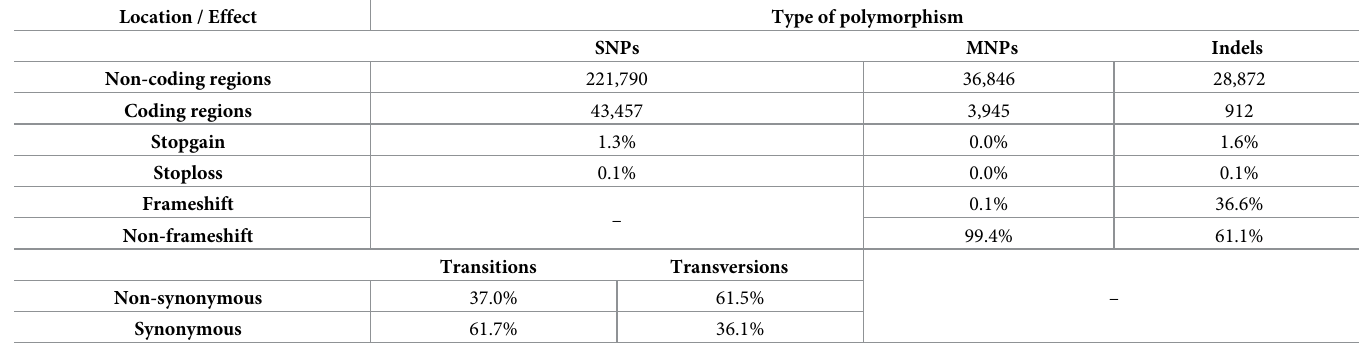
recognition sites were found for one sequence polymorphism. As could be expected based on the input file, polymorphic recognition sites were delivered mostly from SNPs (82.5%) (Table 4). CAPS-convertible fraction reached 86.1, 95.2 and 60.5% for SNPs, MNPs and indels, respectively. Among the identified CAPS markers the top represented restriction enzyme pro- totypes were: MspJ I, Sge I, Fai I and Set I with 1,590, 1,082, 763 and 582 markers, respectively. Out of the 16,093 identified CAPS markers, for 3,331 (20.7%) their constituting recognition site was not found within both 500 bp regions flanking the respective sequence polymorphism. Contribution of SNPs, MNPs and indels in the pool of such single-cut CAPS markers was sim- ilar to that before filtration (Table 4). Within the single-cut fraction the top represented proto- types were: Mae II, Tsp GWI, Hga I and Bsr I with 52, 51, 40 and 36 markers, respectively. Generally, the run time of VCF2CAPS was proportional to the number of DNA polymor- phisms and analyzed recognition sites. In the case of the analyzed population it took ~18 min- utes for the CAPS mining function to check 6,622 polymorphisms for 619 recognition sites on CAPS markers for their single-cut character took ~14 minutes on the same computer. Filtra- tion by groups was taking seconds–for the male-sterile and male-fertile plants from population 398 it revealed 37 CAPS markers which represented 16 DNA polymorphisms.